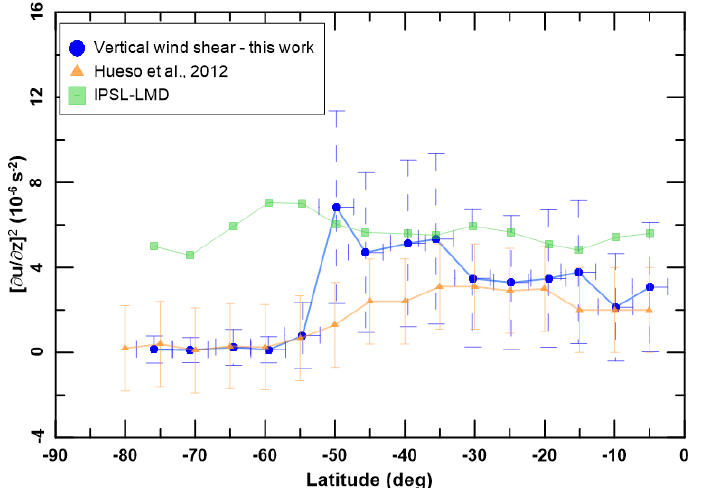
Figure 14. Squared vertical wind shear ( ∂ u / ∂ z ) 2 between the top of the upper clouds (VEx/VIRTIS-M) and the lower clouds (TNG/NICS), using the wind speeds during 11–13 of July 2012 and a vertical separation of about 20 ± 4 km. For comparison, we also display ( ∂ u / ∂ z ) 2 , as estimated by Hueso et al. [21], using only VIRTIS-M data during the years 2006–2008. It is worth noting that modelling simulations predict that the zonal wind at the bottom of the cloud layer is stable (both on the dayside and on the nightside) along all the planetary local times at a given latitude Garate-Lopez and Lebonnois [30], which enables, as a first approach, an estimation of a latitudinal vertical shear wind’s profile on the southern hemisphere of Venus. For comparison reasons, a prediction profile from the IPSL-VGCM is also shown in light green